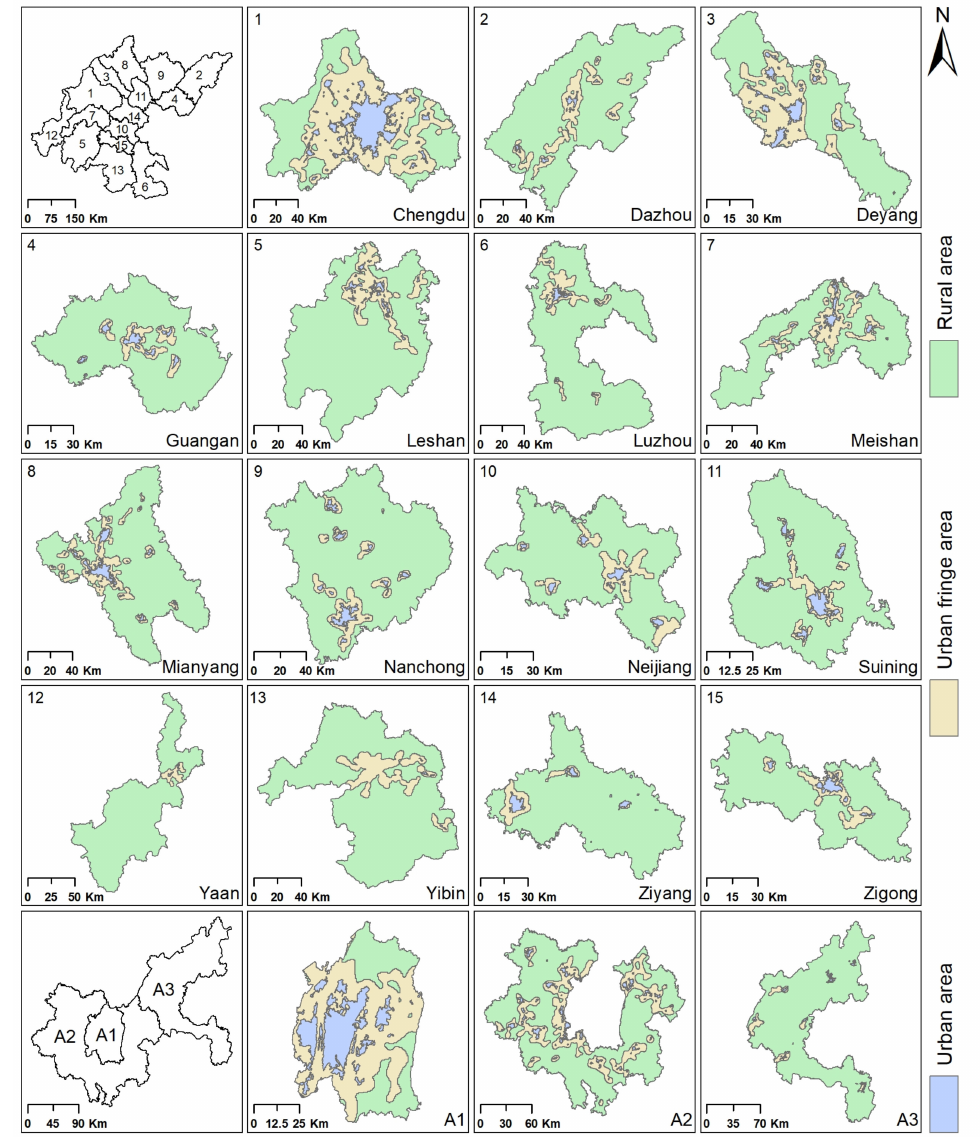
Figure 11. UFA identification